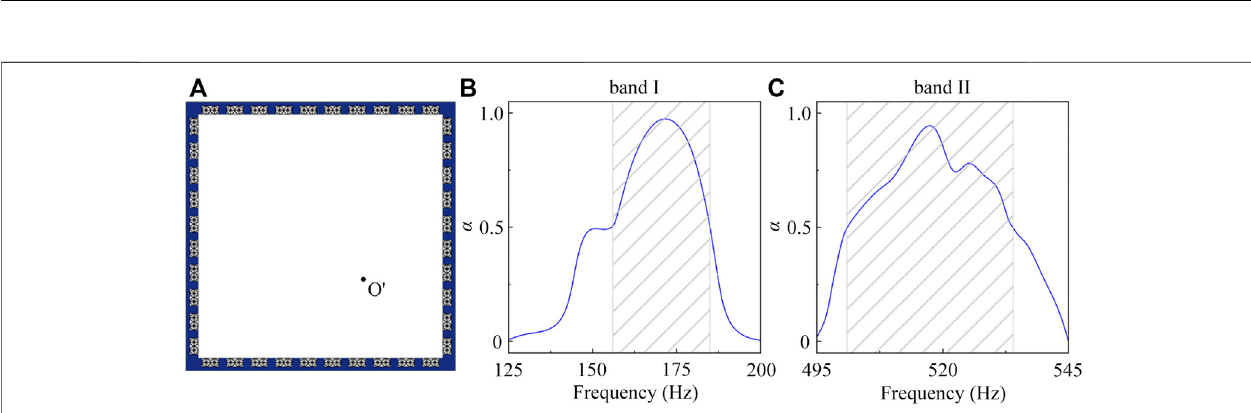
FIGURE 6 | (A) Schematic of a barrier-free anechoic room with a cylindrical sound source placed at the point O ’ . Simulated absorption spectra created by the barrier-free anechoic room around the (B) bands I and (C) II. The absorption coef fi cients are larger than 0.5 in the black shaded